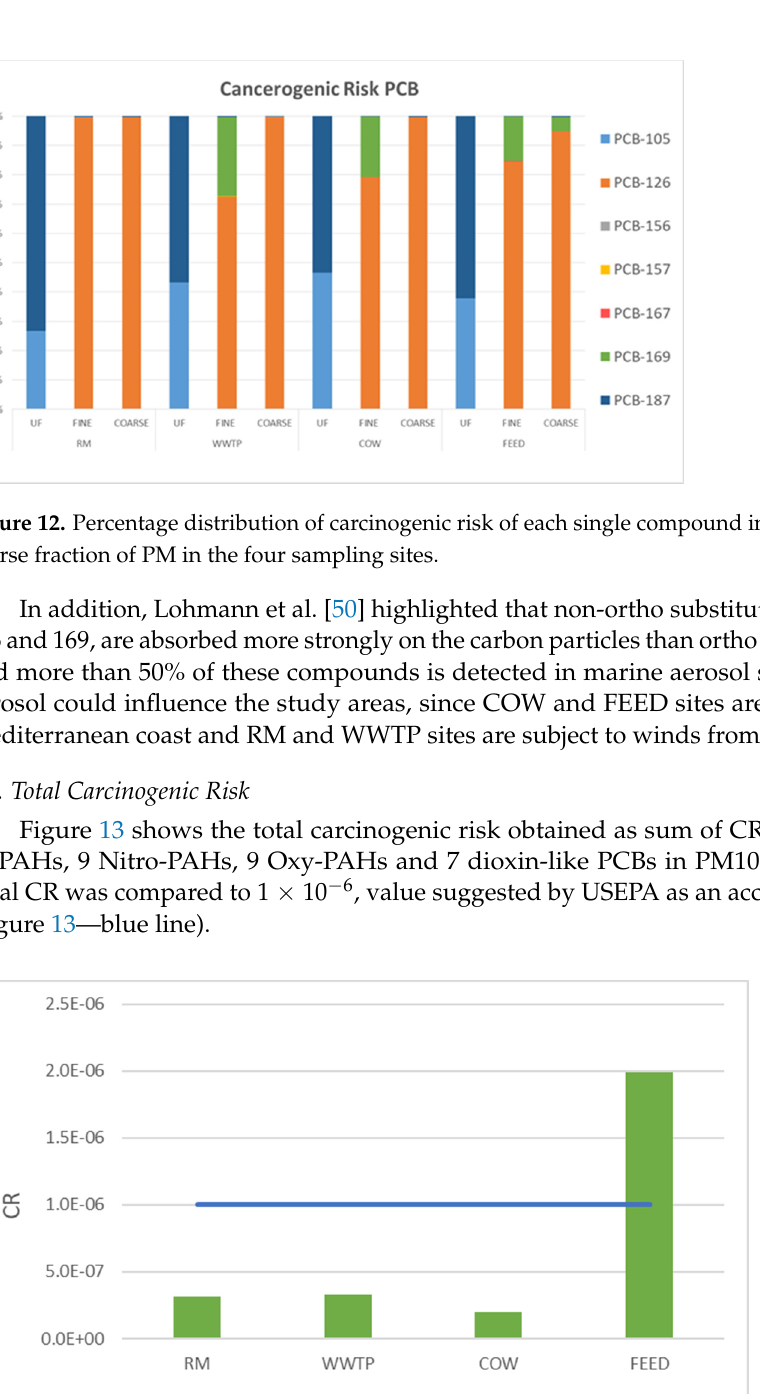
Figure 13. Total carcinogenic risk obtained as sum of CR associated with PAHs, Nitro-PAHs, Oxy- PAHs and dioxin-like PCBs in PM10 and for all sites.